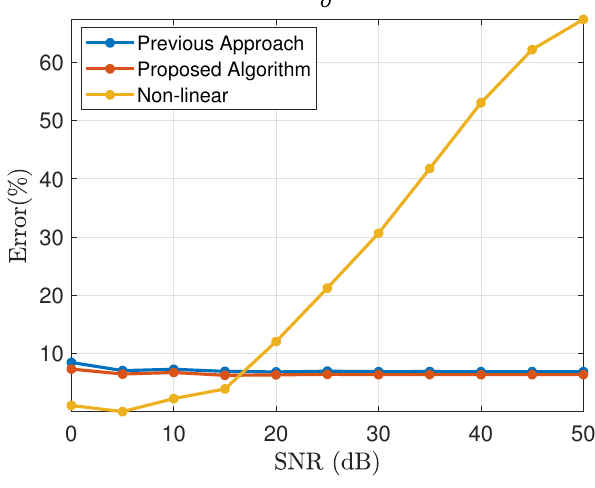
Figure 7. Parameter estimation of the Diffusion Arc. Blue line shows the % error in parameters estimation using previous approach. % error in parameters estimation using the proposed approach and non-linear approach is shown in red and yellow.